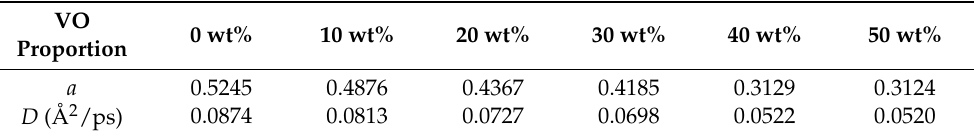
Table 4. The slope of fitting line of the MSD curve and the diffusion coefficient of water molecules in each mixed oil model with 3 wt% of water